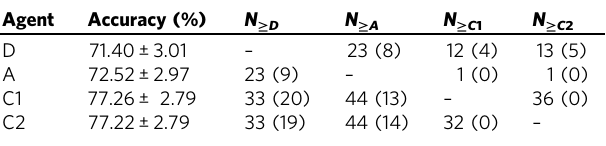
ThemeanaccuracyofthedoctorsD,associativeAandcounterfactualalgorithms(C1 = expected suf fi ciency, C2 = expected disablement), averaged over all experiments. N ≥ K gives the number of trials (one for each doctor) where this agent achieved a mean accuracy the same or higher than the mean accuracy of agent K ∈ {D, A, C1, C2}. The bracketed term is the number of trials where the agent scored the same or higher accuracy than agent K to 95% con fi dence, determined by a one sided binomial